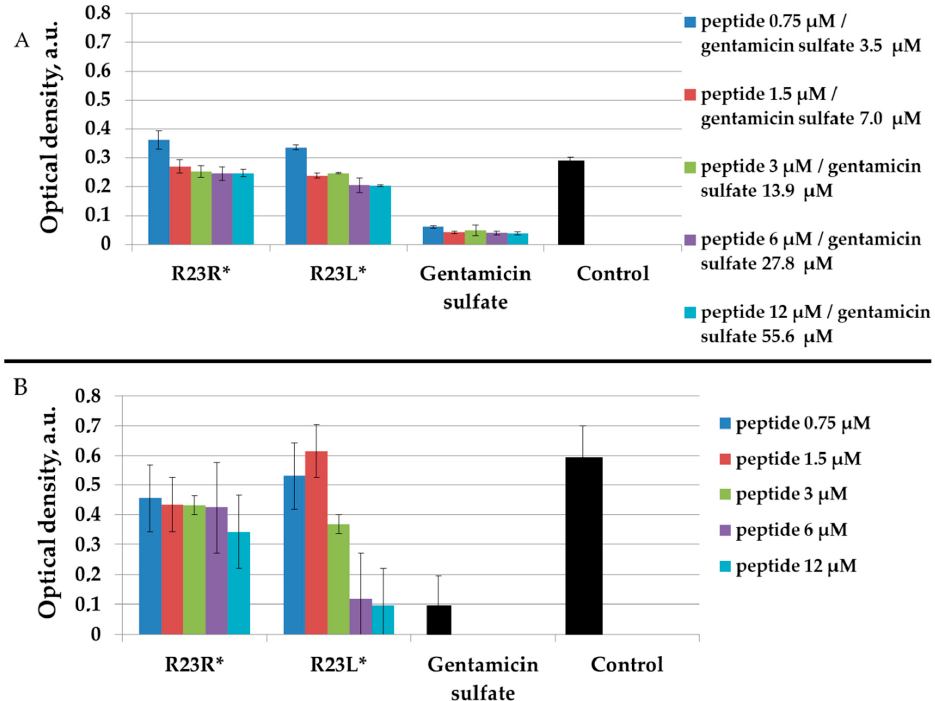
Figure 4. Inhibitory activity of R23R* and R23L* during 16 h of co-incubation the peptides with the cells P. aeruginosa PA103 ( A ) and ATCC 28753 ( B ). Different concentrations ( A ) and only 1700 µM ( B ) of gentamicin sulfate were used as positive control of antimicrobial effect. The tested bacteria strain without the addition of peptide were used as negative control.